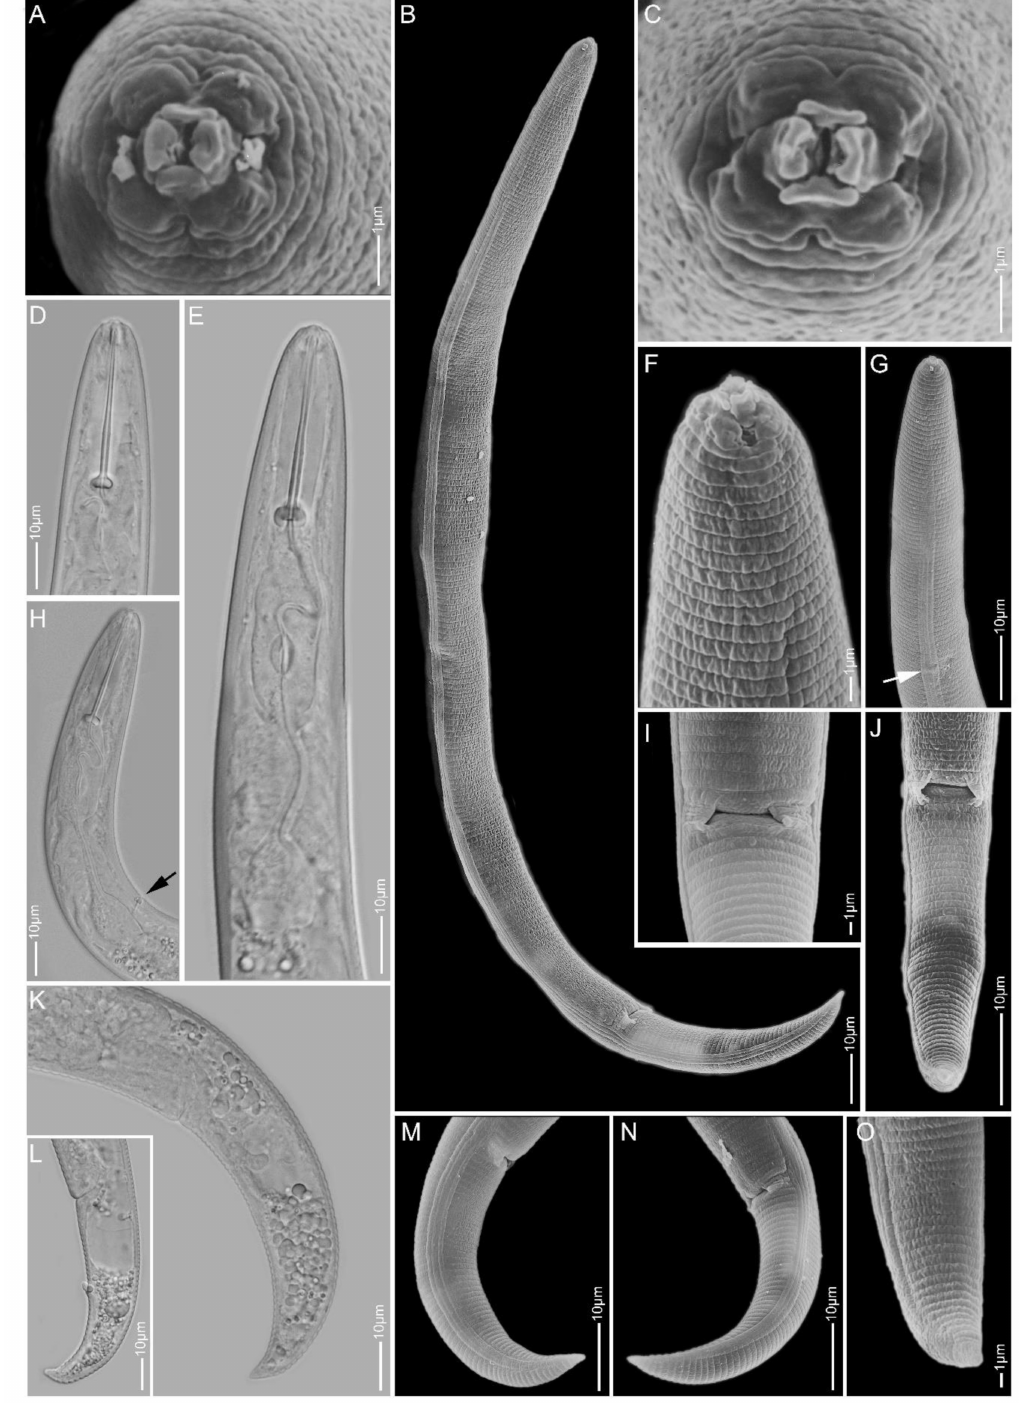
Figure 9. Light and scanning electron microscopy images of Paratylenchus neoamblycephalus females: ( A , C ) face view; ( B ) total body; ( D – H ) anterior region; ( I – O ) tail region; arrows pointed to secretory–excretory pore in ( H ) and deirid in ( G